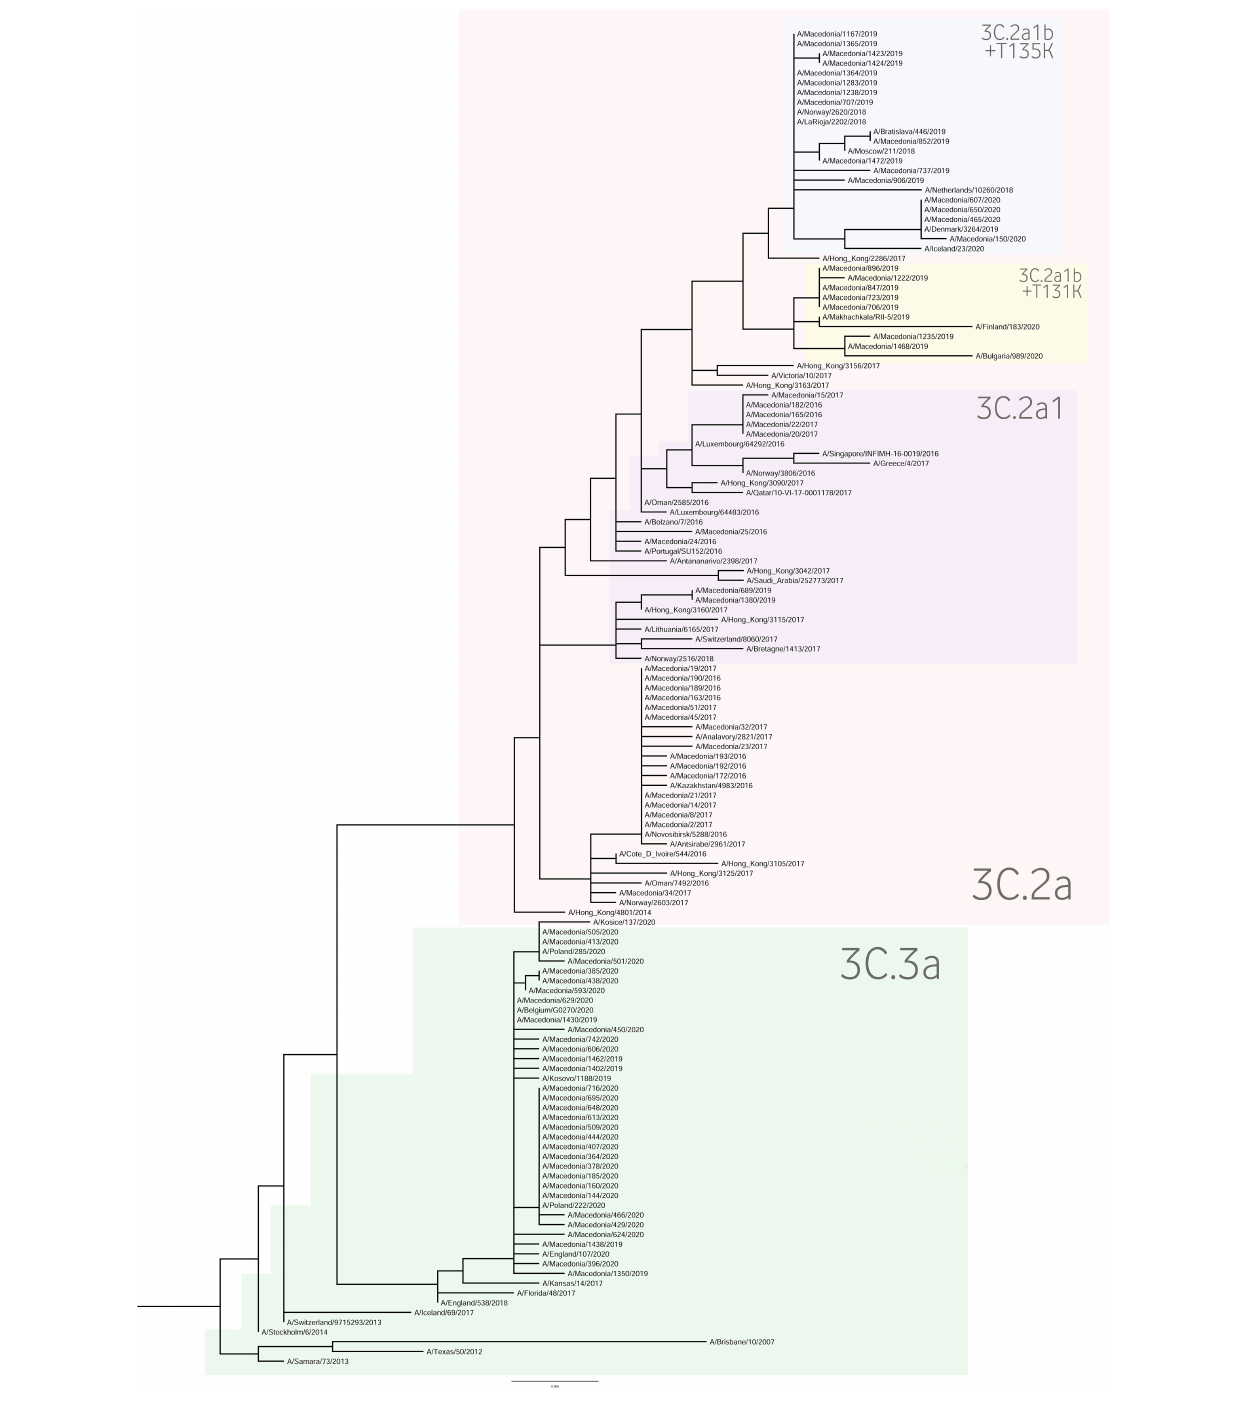
conserved inner shell residues, which interact directly with the sialic acids, as well as the framework residues. However, N270K (100%) and N369K (100%) substitutions were found near the catalytic sites, whereas the N248D